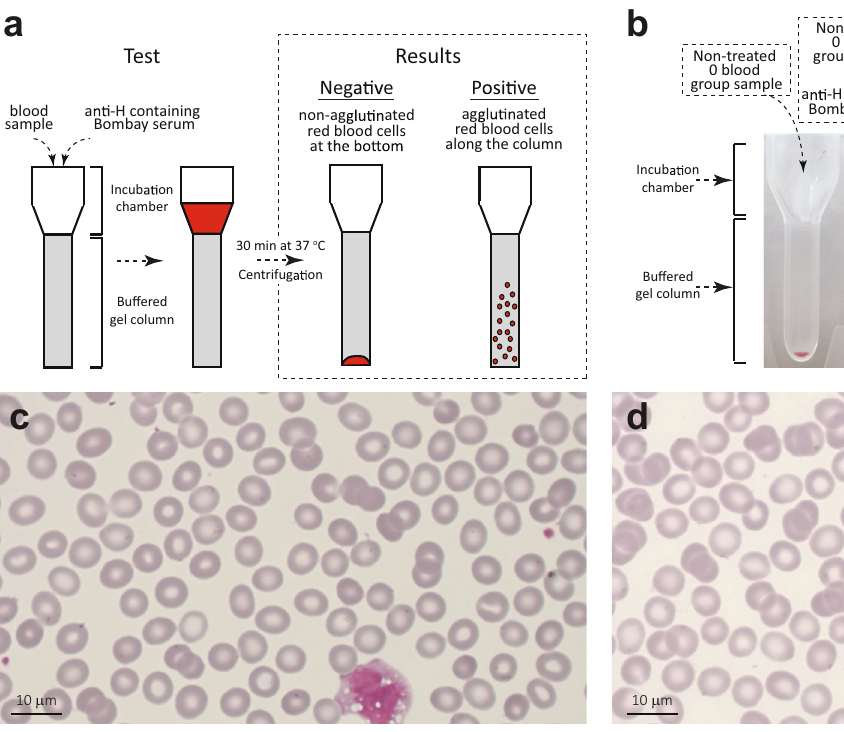
Fig. 6 | Turning universal O into rare Bombay-type blood. a Schematic repre- sentationofagglutinationassaywithDGGelcardsfromGrifols(DiagnosticGrifols, S.A.) and positive and negative results representation. b Agglutination experiment resultspicture;negative/non-agglutinationinnon-treatedObloodgroupsamplein the fi rst column and positive/agglutination in the second column in non-treated O blood group sample in contact with H antibodies naturally containing Bombay serum as a negative and positive control, respectively; negative/non-agglutination